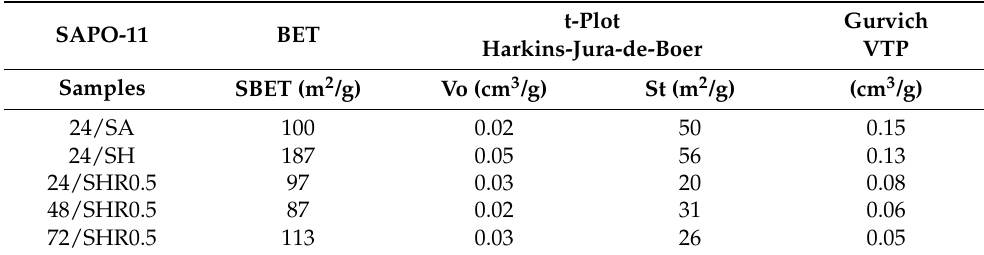
Table 5. Textural parameters result obtained from N 2 adsorption and